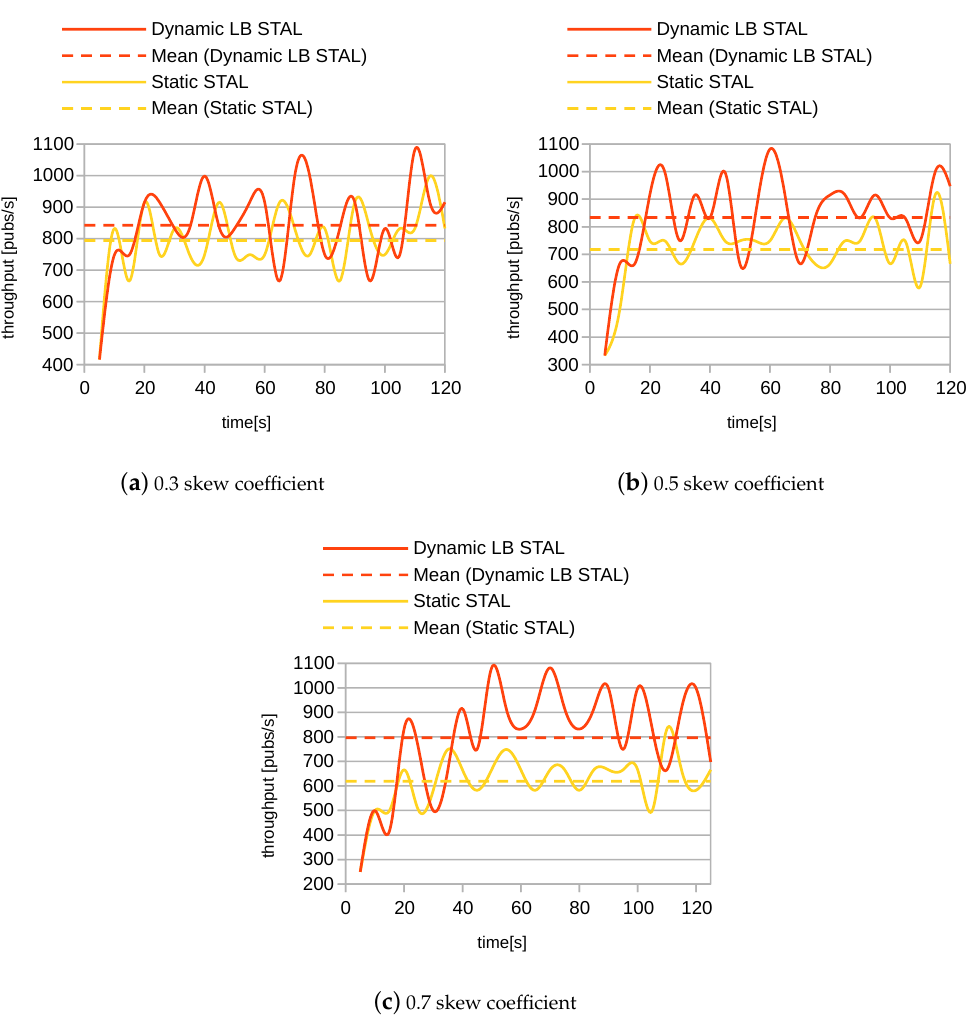
Figure 6. Throughput against time for different modes of the sPS